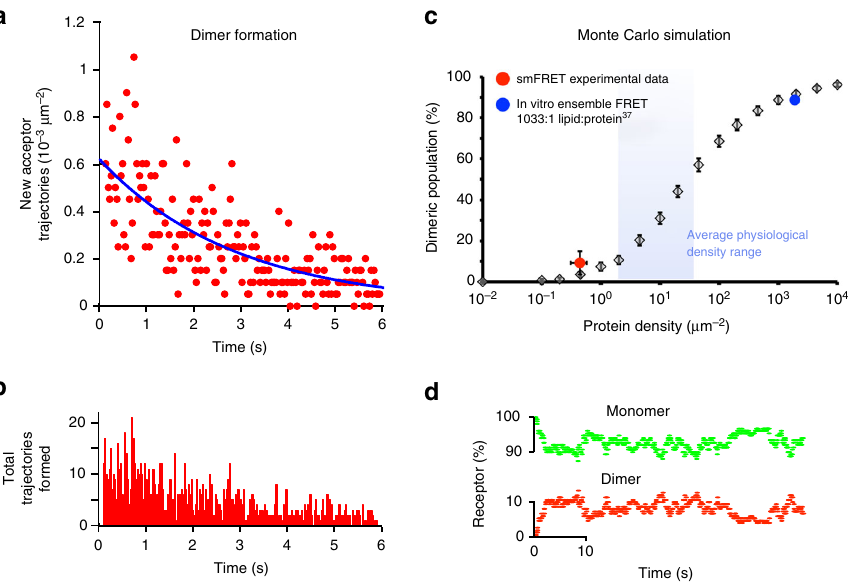
Fig. 3 Dynamics of dimer population. a Experimental data: rate of Cy3 – Cy5 dimer formation as observed by the formation of new acceptor trajectories ( n = 19 videos). The observed frequency of dimer formation decreases with time due to photobleaching. Exponential fi tted model (blue line) enables extrapolation to zero photobleaching and subsequent calculation of total dimer formation rate. b Experimental absolute frequency of observed dimer formation events. c The dimeric population observed during Monte Carlo simulations at different protein density parameterised by measured single- molecule receptor dynamics is shown. Simulations at the receptor density used in single-molecule experiments correlate well with experimental observations (red dot), and ensemble FRET measurements from previous studies at four orders of magnitude higher receptor density (blue dot). Blue shaded area highlights the reported physiological range of average cell surface receptor densities for NTS1 (2 – 40 μ m − 2 ) 45 . d Monte Carlo simulation of single-molecule experimental conditions of receptor density and number of receptors (see also Supplementary Movie 4). Dynamic equilibrium illustrates fl uctuation of monomer and dimer populations over the experimental timescale, explaining the observed variance in dimer formation ( a , b ) and dynamic equilibrium monomer-dimer distribution ( c — red spot error bars, see also Supplementary Fig.